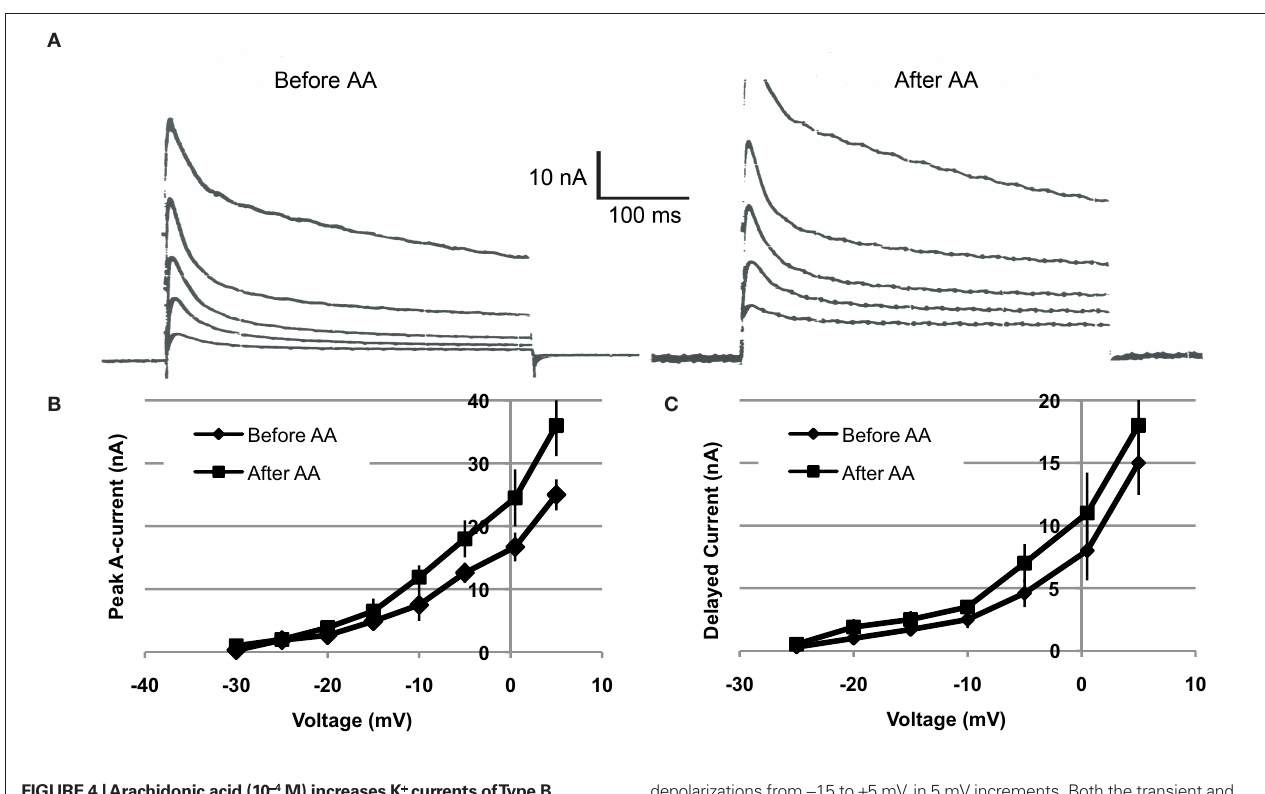
FigurE 4 | Arachidonic acid (10 − 4 M) increases K + currents of Type B photoreceptors. (A) Left traces: Examples of currents elicited by depolarization of a voltage-clamped type B photoreceptor, just prior to AA exposure. Right traces: Currents from same cell recorded at same test potentials, 15 min following exposure to AA. Current traces depicted were elicited by